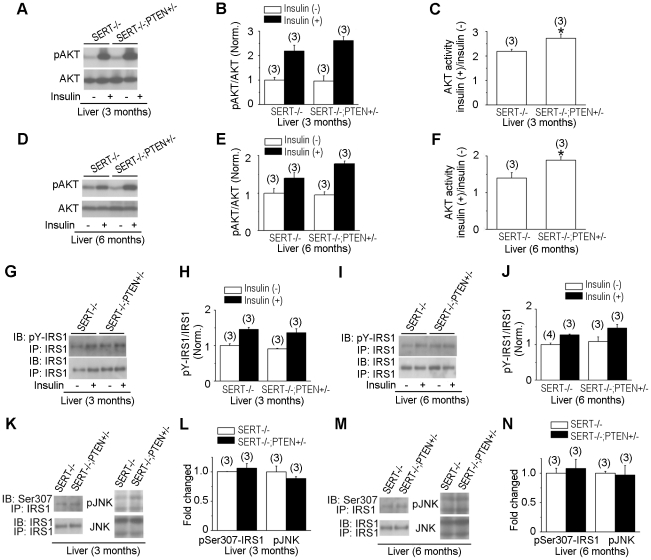
Western blot analysis of insulin signaling component activity in SERT−/−;PTEN+/− mice.
A–F. AKT activity in the liver of 3- and 6-month old SERT−/−; PTEN+/− and SERT−/− mice was evaluated by AKT Ser473 phosphorylation (pAKT) before and after insulin injection. G–J. IRS1 activities in the liver of 3- and 6-month old SERT−/−;PTEN+/− and SERT−/− mice were evaluated by tyrosine-phosphorylated IRS1. IRS1 was first immunoprecipitated with anti-IRS1 antibody (IP-IRS1) and then blotted with anti-IRS1 (IB-IRS1) or anti-phosphotyrosine antibodies (IB-pY-IRS1). A, D, G and I show images of representative western blot results. B and E show densitometric quantification of the ratio of pAKT vs. total AKT, and H and J show densitometric quantification of the ratio of pY-IRS1 vs. total IRS1. Insulin (−), basal activity determined from the tissues collected from16 h fasted mice. Insulin (+), insulin-induced activity determined from the tissues collected from mice 20 min post insulin injection. The value of WT treated with insulin and mutants with and without insulin treatment is normalized to that of WT without insulin treatment. C and F show the ratio of pAKT before and after insulin injection for each genotype. The net increase in pAKT amounts following insulin injection was elevated in SERT−/−; PTEN+/− mice relative to SERT−/− mice, *p<0.05, Student's t-test. K–N. Western blot analysis of phospho-JNK (pJNK) and phospho-Ser307-IRS1 in the liver of 16 h fasted 3- and 6-month old SERT−/−; PTEN+/− and SERT−/− mice. K and M show images of representative western blot results. L and N show densitometric quantification of pJNK and pSer307-IRS1. The amounts of phosphorylated proteins were normalized to that of total corresponding proteins. Shown are the relative values of SERT−/−; PTEN+/− mice to SERT−/− mice, with the average value from SERT−/− mice defined as 1. Data represent mean ± SEM. The number of mice analyzed is indicated in parentheses.